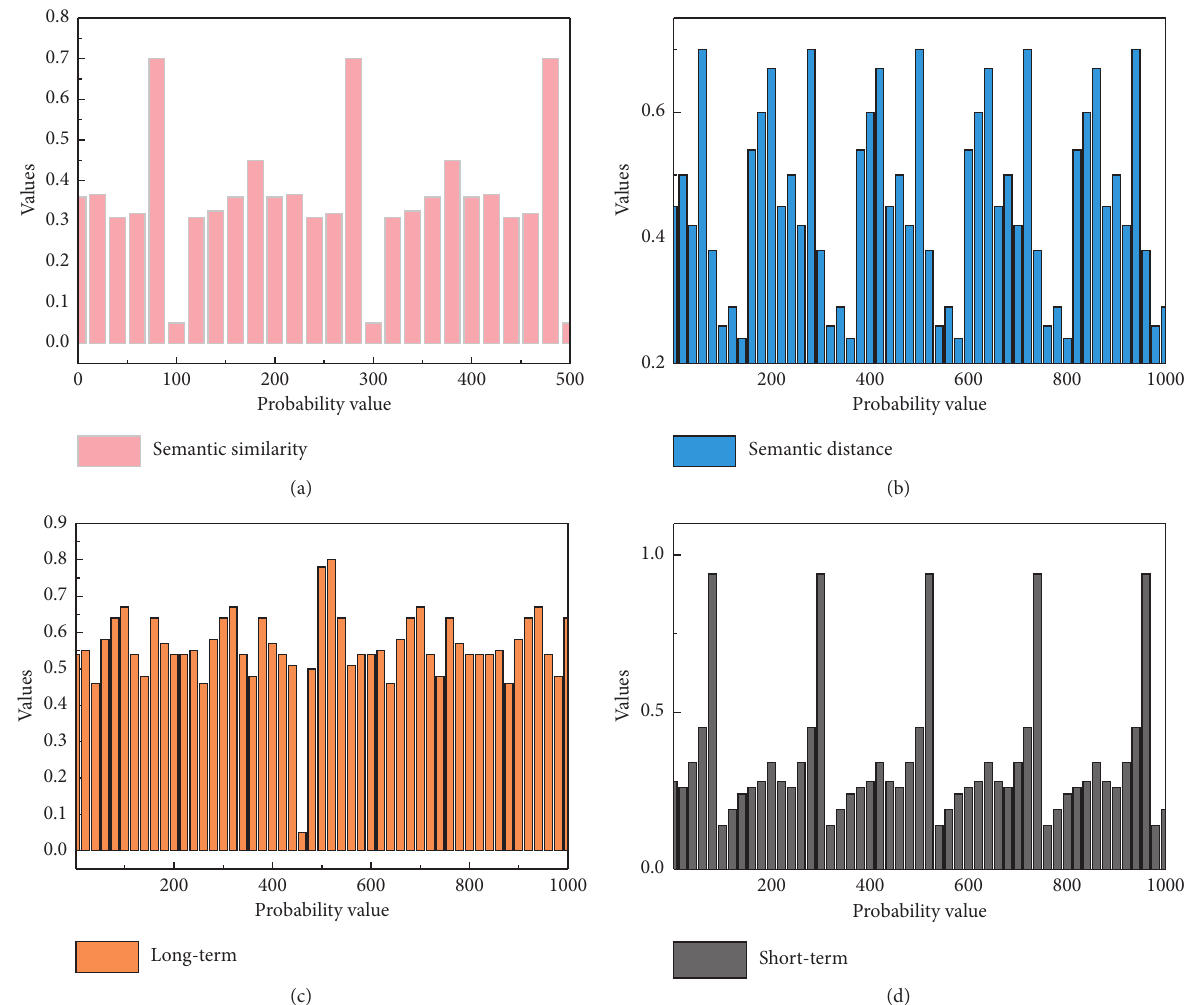
Figure 5: Relationship between semantic similarity and semantic distance.